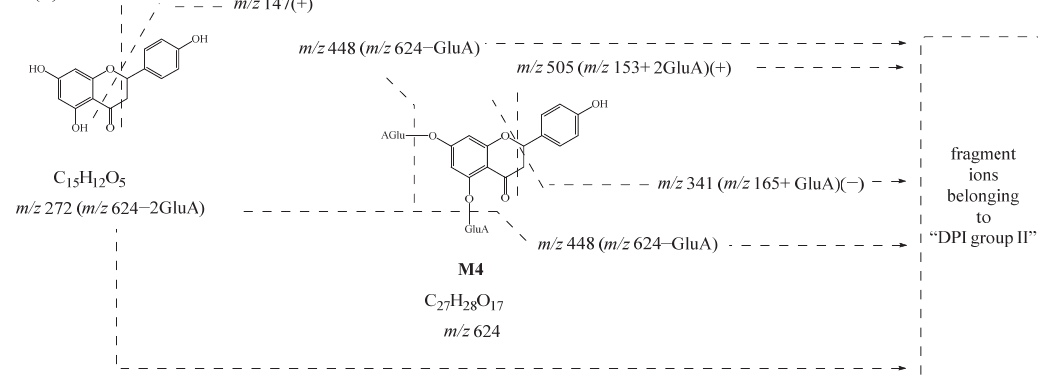
Figure 3. Possible cleavage pathway of M4 .